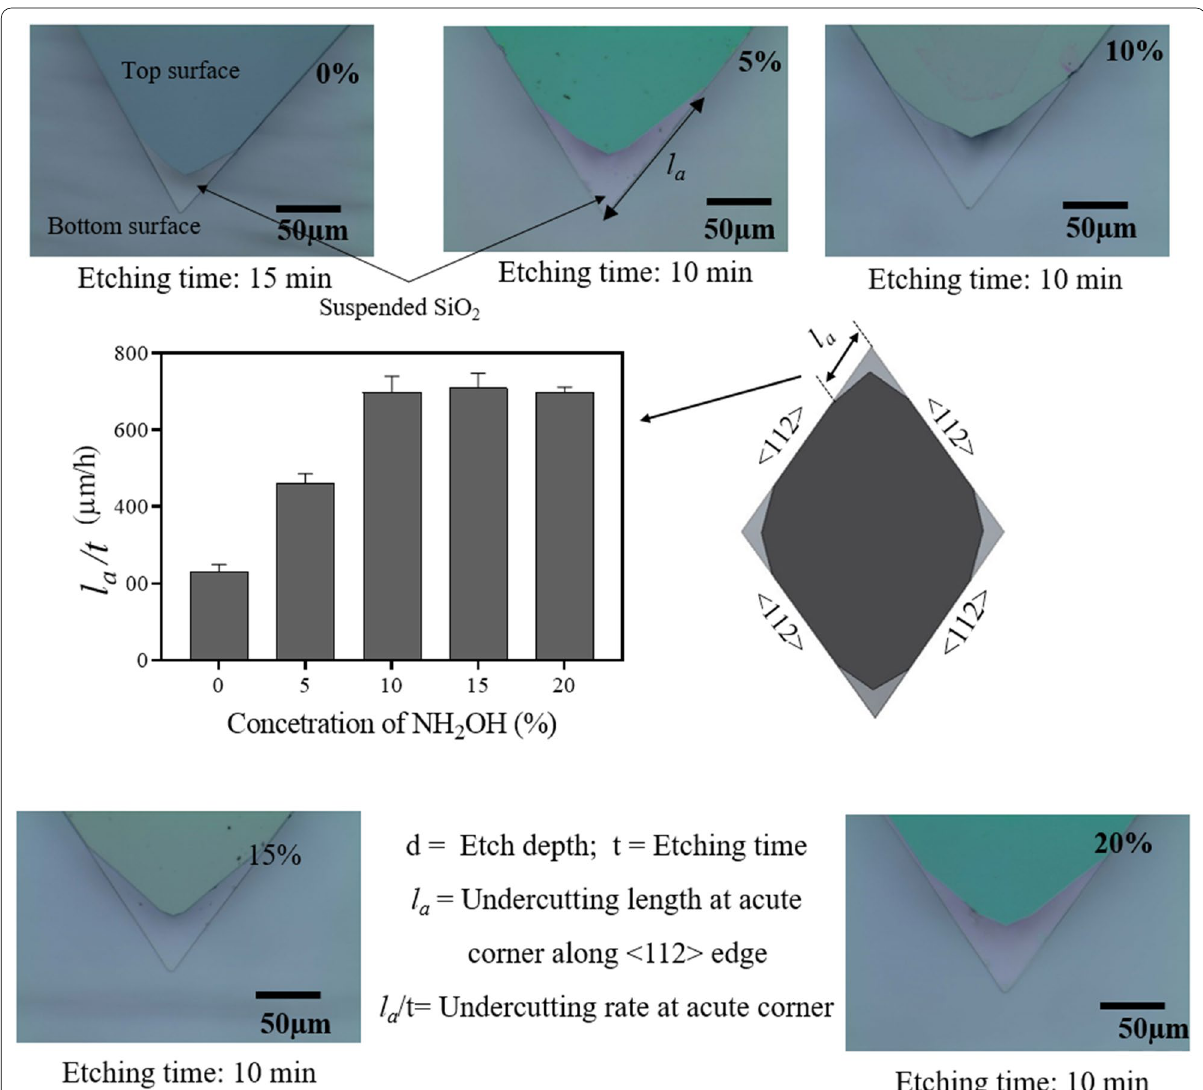
Fig. 56 Undercutting at acute corners on Si{110} wafer surface in pure and different concentrations of NH 2 OH-added 5 wt% TMAH at 70